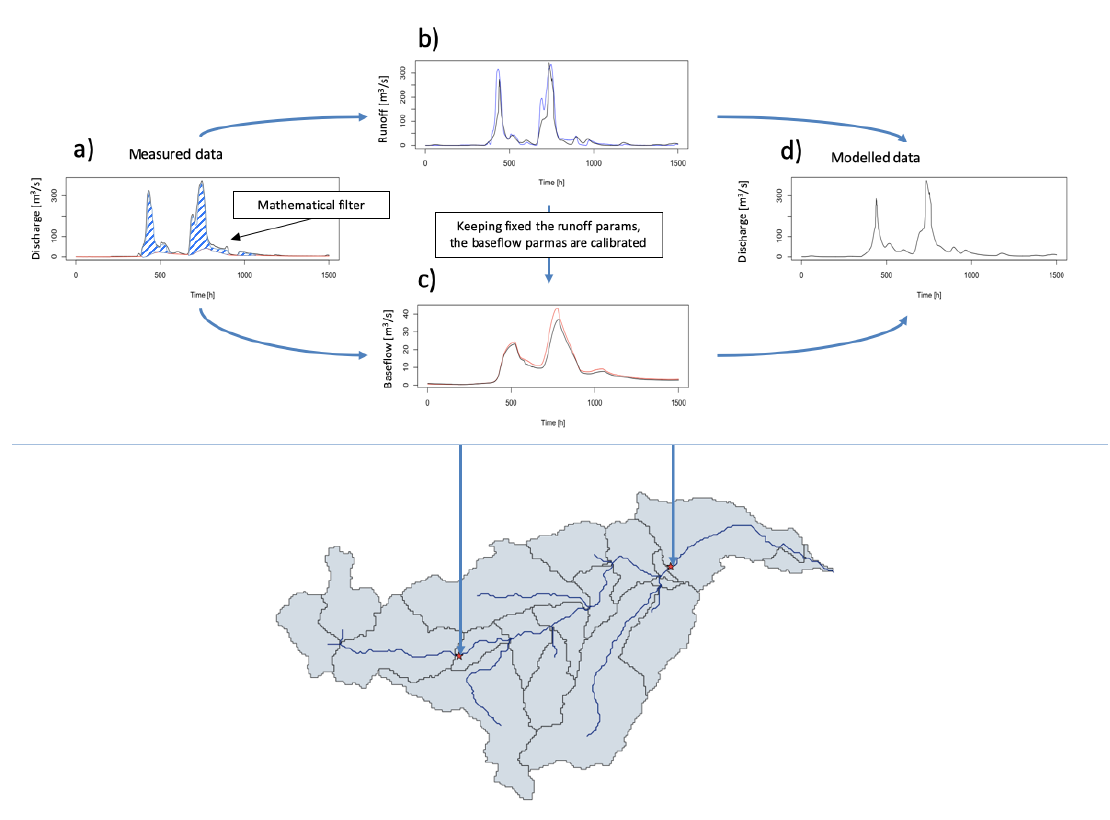
Figure 3. Flowchart of the calibration strategy: first, the discharge components, baseflow (blue line) and runoff (red line), were extracted from the total discharge ( a ); then, the parameters were calibrated against the runoff series ( b ) and against the baseflow series ( c ); finally, all the parameters were recalibrated against the total discharge to further improve the results ( d ). If multiple monitoring points were available (red stars), then the procedure was repeated for each